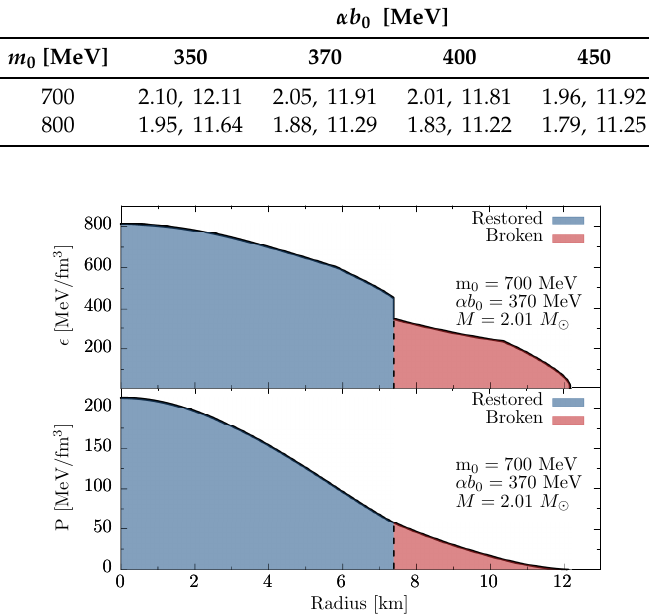
Figure 4. Profiles of the energy density ( top ) and pressure ( bottom ) for a neutron star with M = 2.01 M (cid:12) for m 0 = 700 MeV and α b 0 = 370 MeV. The red regions show the phase, where the chiral symmetry is broken, in the blue regions chiral symmetry is restored. The phases are separated with the dashed